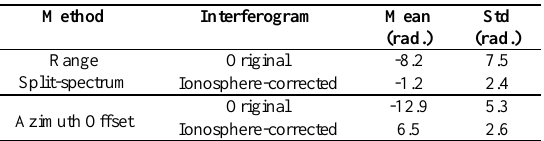
Table 2. The mean and standard deviation values of differential interferometric phase before and after ionospheric correction for Yushu coseismic interferogram are